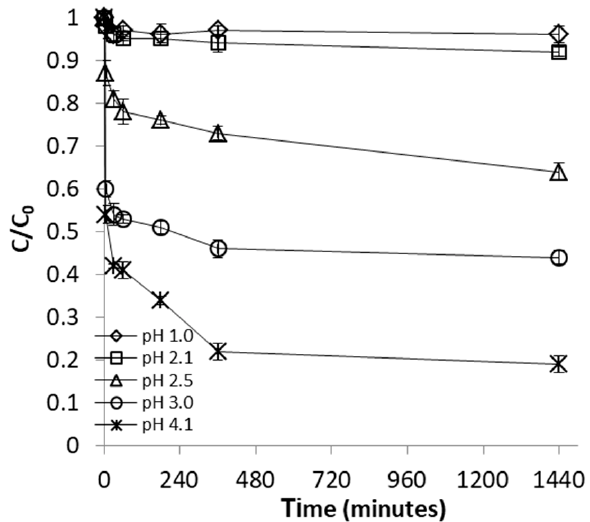
Figure 1. Effect of pH on Fe II removal by walnut-shell powder WSP. The lines are not fitting models; they simply connect points to facilitate visualization.